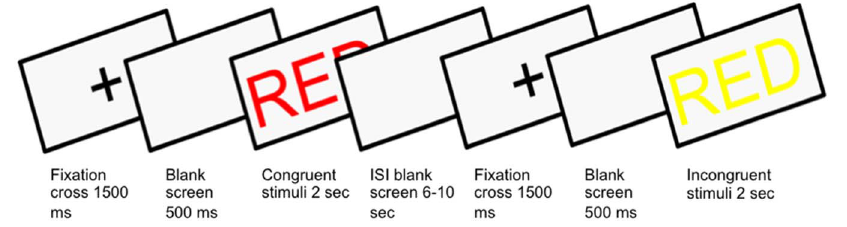
Figure 1. Example of one congruent and incongruent trial showing the fMRI set-up. Stimuli were presented in Swedish, but the English translation is used here for illustrative purposes.